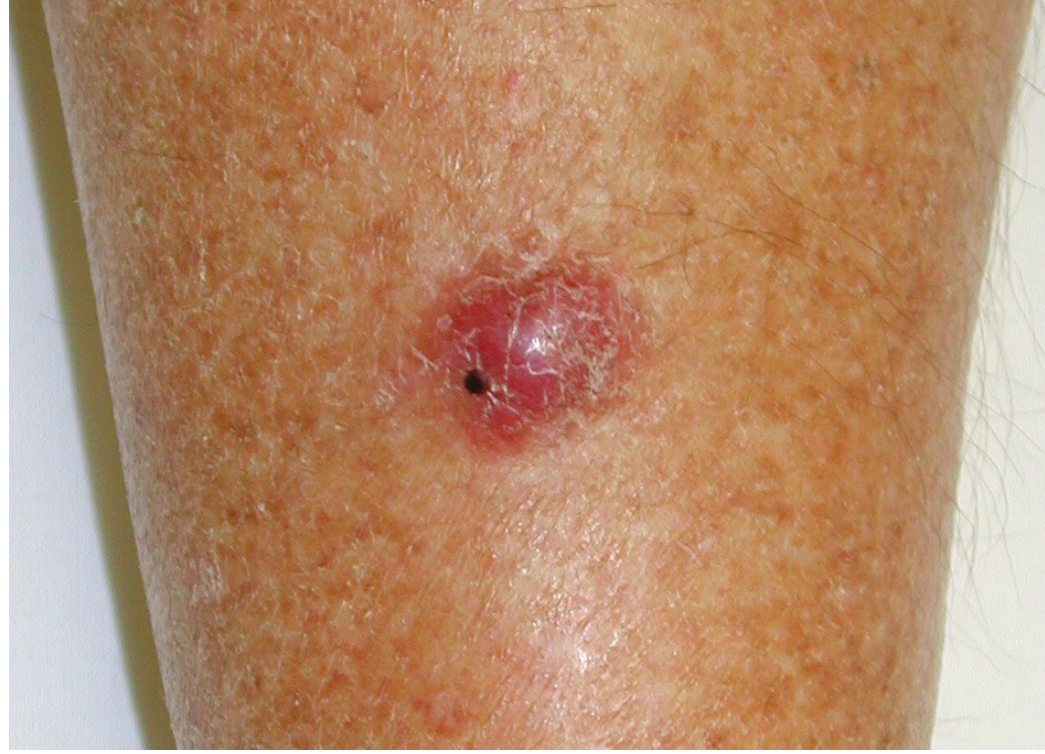
Figure 2. Merkel cell carcinoma. A typical MCC nodule present on the leg of a patient. Image credit to Howard Peach, Leeds Teaching Hospitals NHS Trust,